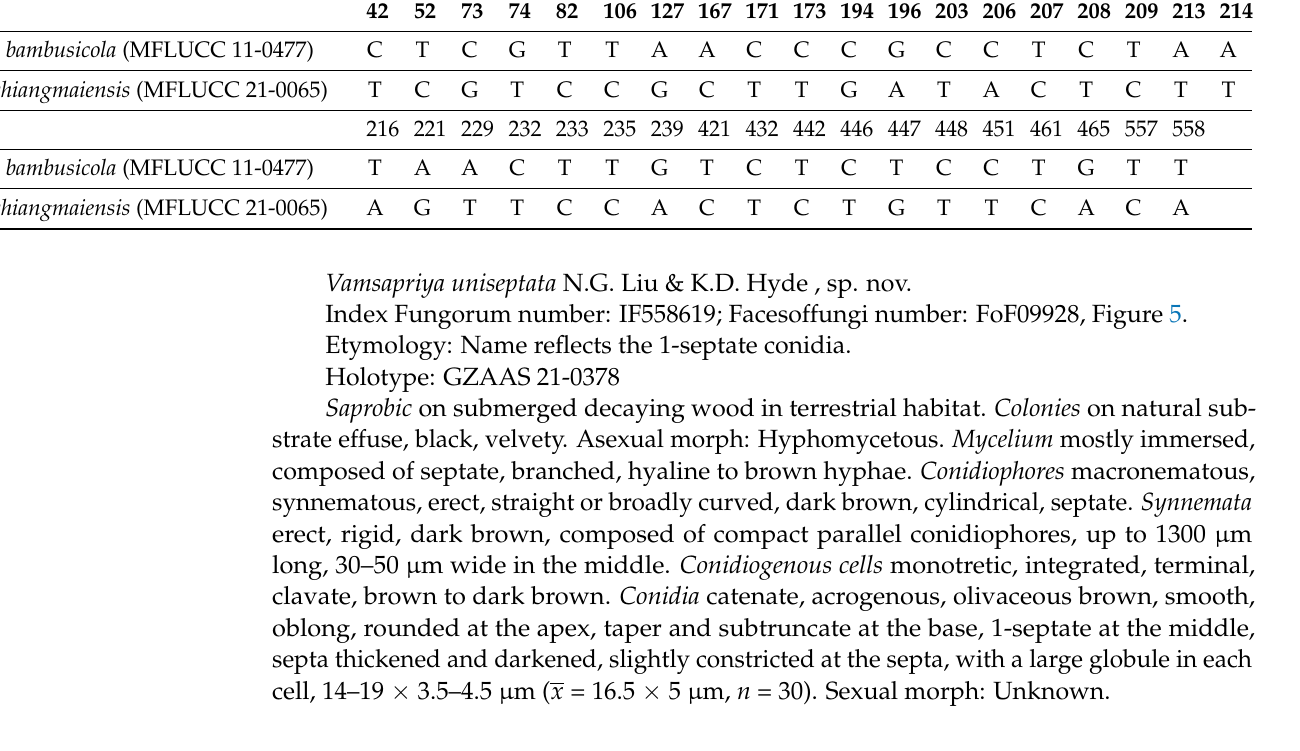
Table 4. Nucleotide differences in the ITS regions of V. bambusicola and V. chiangmaiensis . Numbers are in reference to the nucleotide position of DNA sequences ( V. bambusicola ) submitted in GenBank.